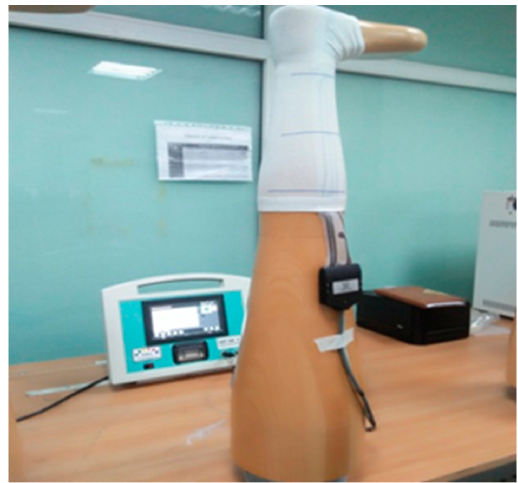
Figure 4. A medical stocking tester (MST) and MK V pressure measurement device.